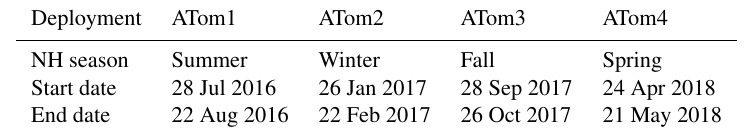
Table 1. ATom campaign deployment seasons and start and end dates. Full details on stops can be found online (ATom, 2016).